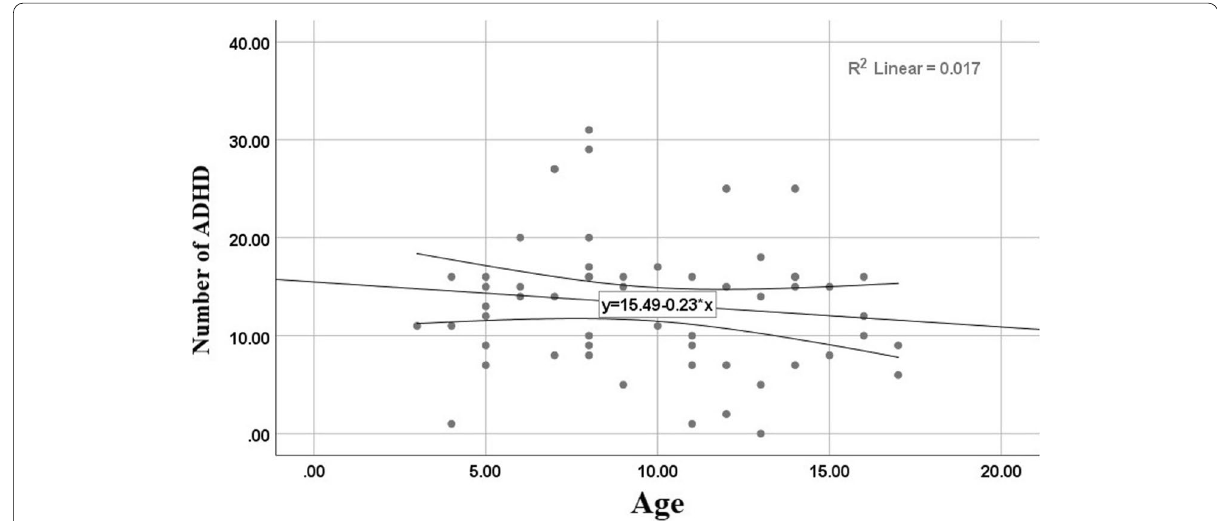
Fig. 2 Correlation between ADHD and age-related